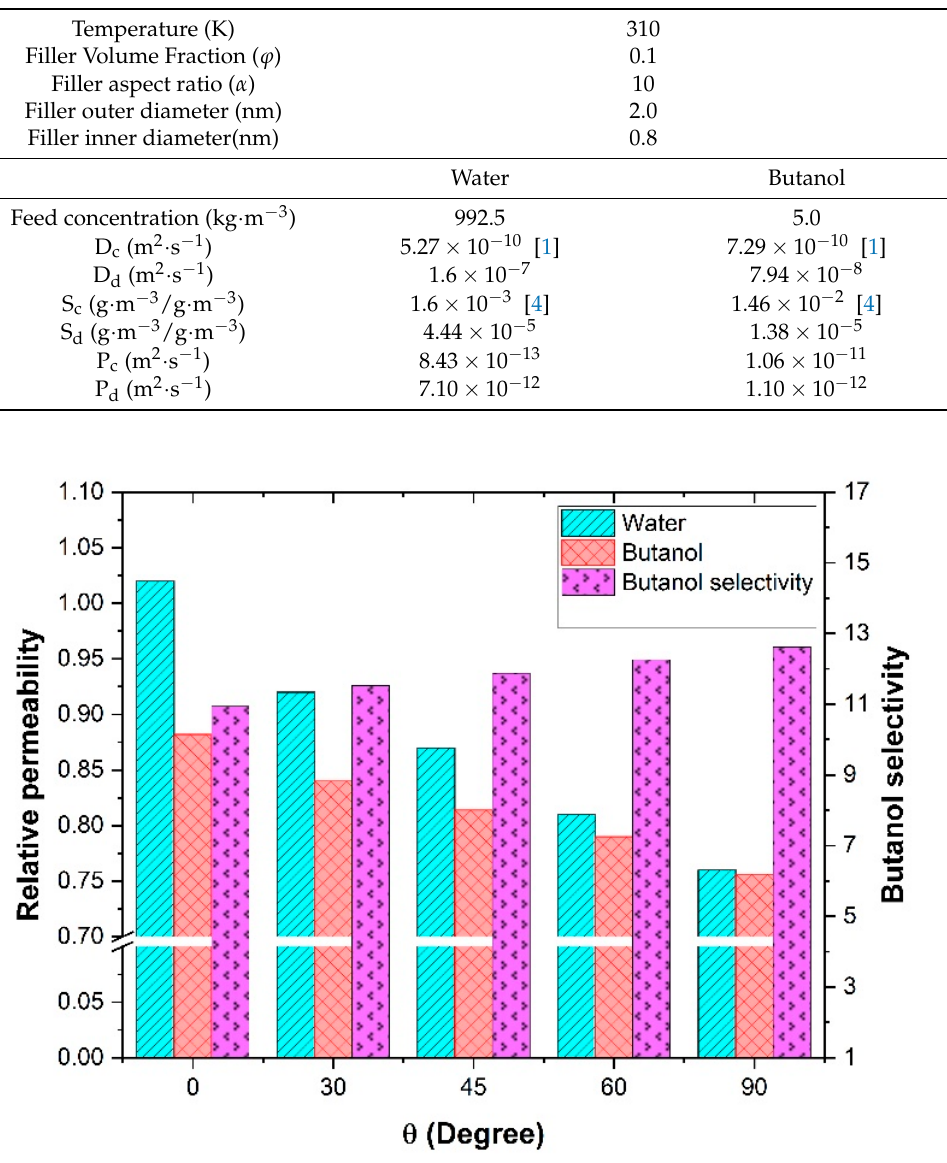
Figure 9. Water and butanol relative permeability and butanol selectivity at different orientations of the nanotubes for a length-to-diameter aspect ratio α of 10.